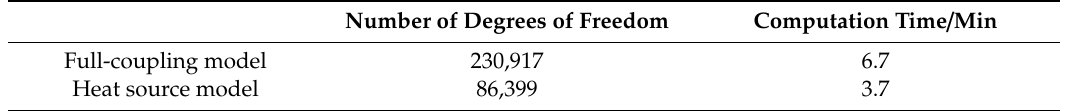
Table 5. Comparison of computation e ffi ciency.